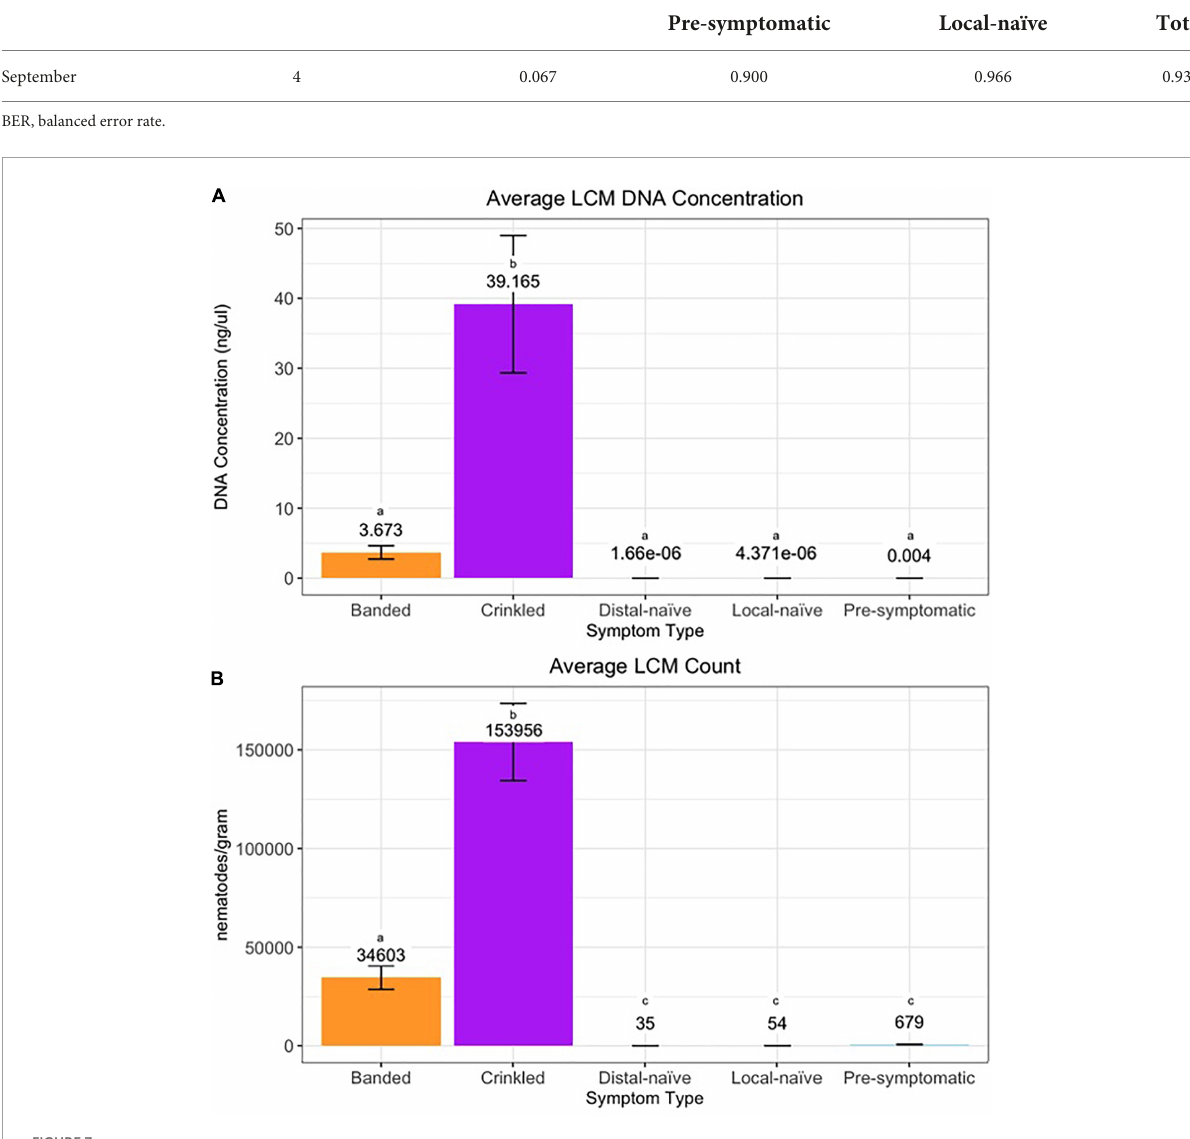
FIGURE7 (A) DNA concentration and (B) count per symptom type of Litylenchus crenatae mccannii (LCM). Error bars represent the standard error. Actual DNA concentration and nematode counts are listed above the bars and significant differences ( p < 0.05) between symptom types are represented by different